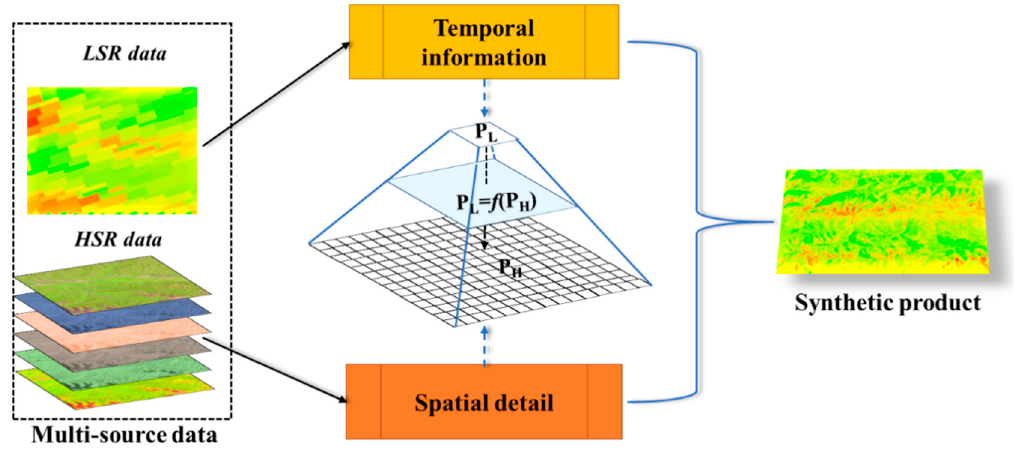
Figure 2. Diagram of the pixel-based multi-spatial resolution adaptive fusion modeling framework for multi-source data fusion.